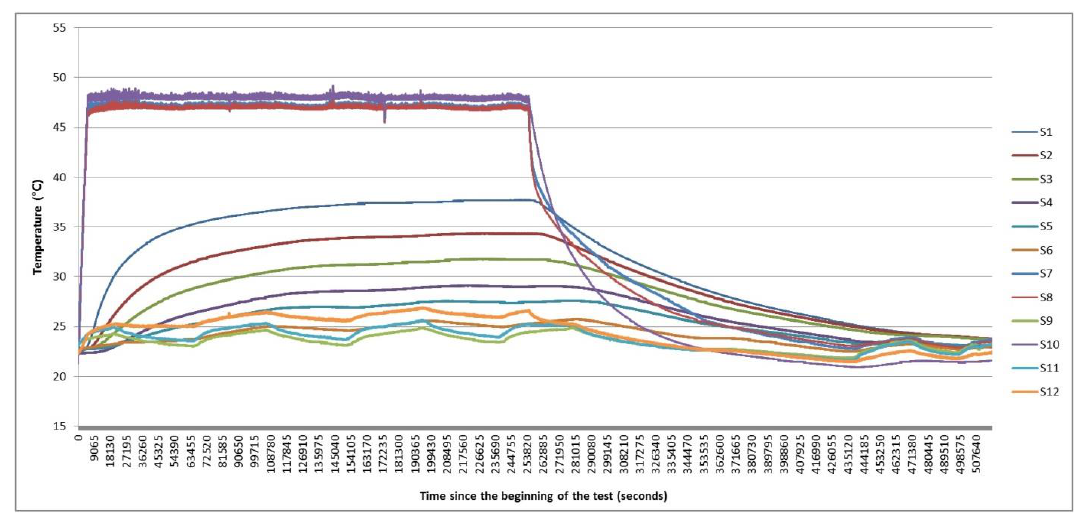
Figure 8. Measurements of the set of temperature sensors used in the experimental setup.